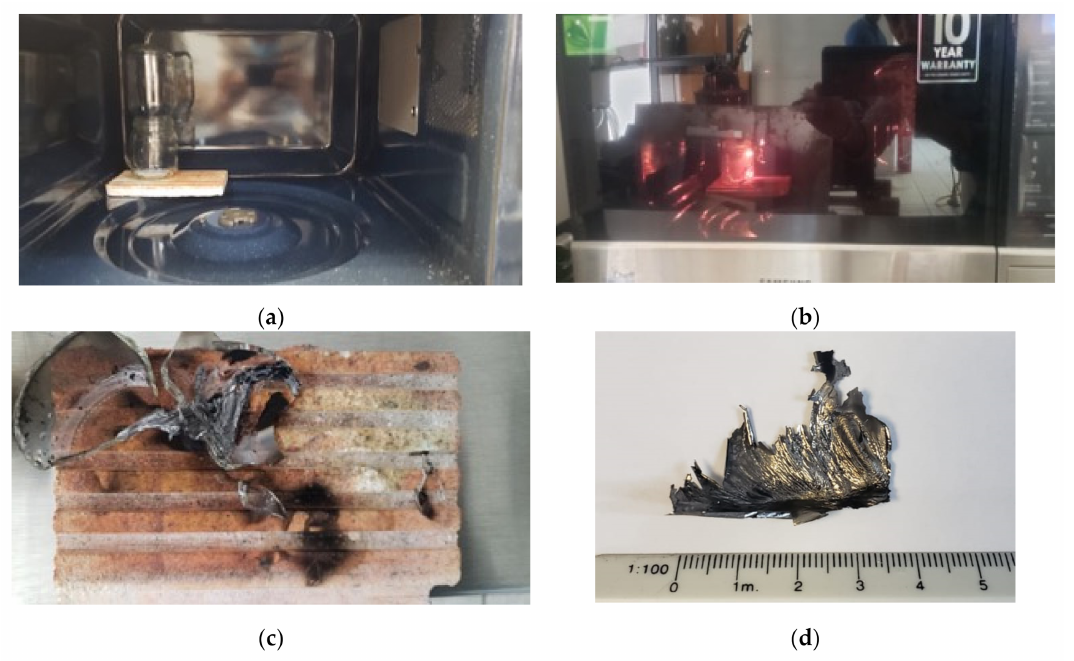
Figure 5. ( a ) Placement of the container, ( b ) generation of the electric arc in the microwave cavity, ( c ) detachment of the carbon film from the substrate, ( d ) comparison of the carbon